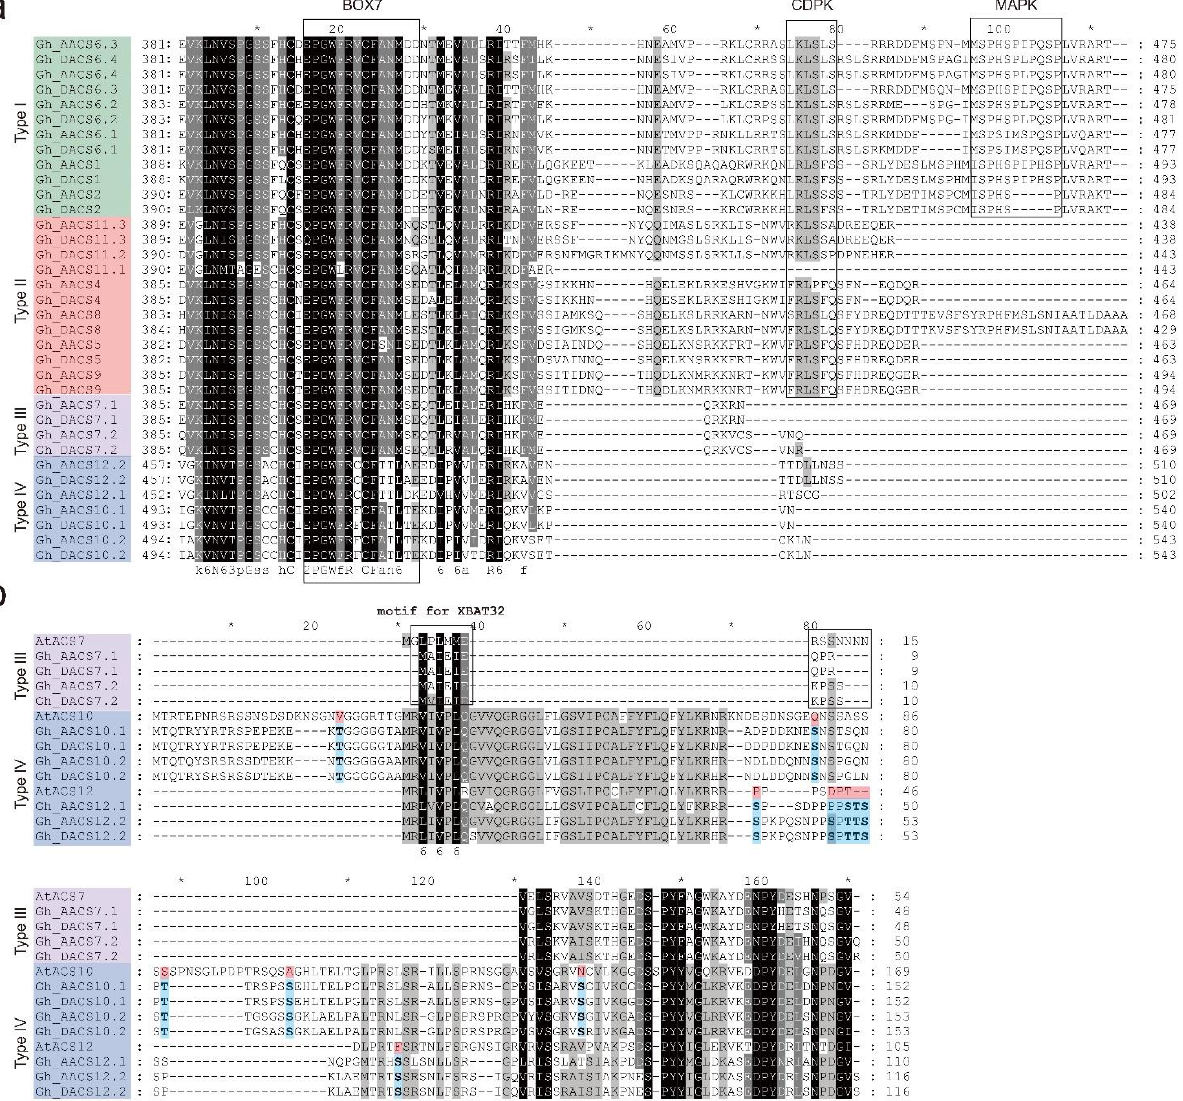
Figure 2. Comparison of the N-terminal and C-terminal domains in ACS proteins: ( a ) Multiple sequences alignment of GhACS proteins by ClustalW. The C-terminal sequences are shown. The rectangles indicate the conserved BOX7, CDPK, and MAPK motifs. ( b ) Multiple sequences alignment of the type III and IV GhACS proteins by ClustalW. The N-terminal sequences are shown. The black boxes indicate the conserved short XBAT32 regions. Possible phosphorylation sites (Ser/Thr) are in bold font. Amino acid differences between the GhACS and AtACS proteins are highlighted using different colors.